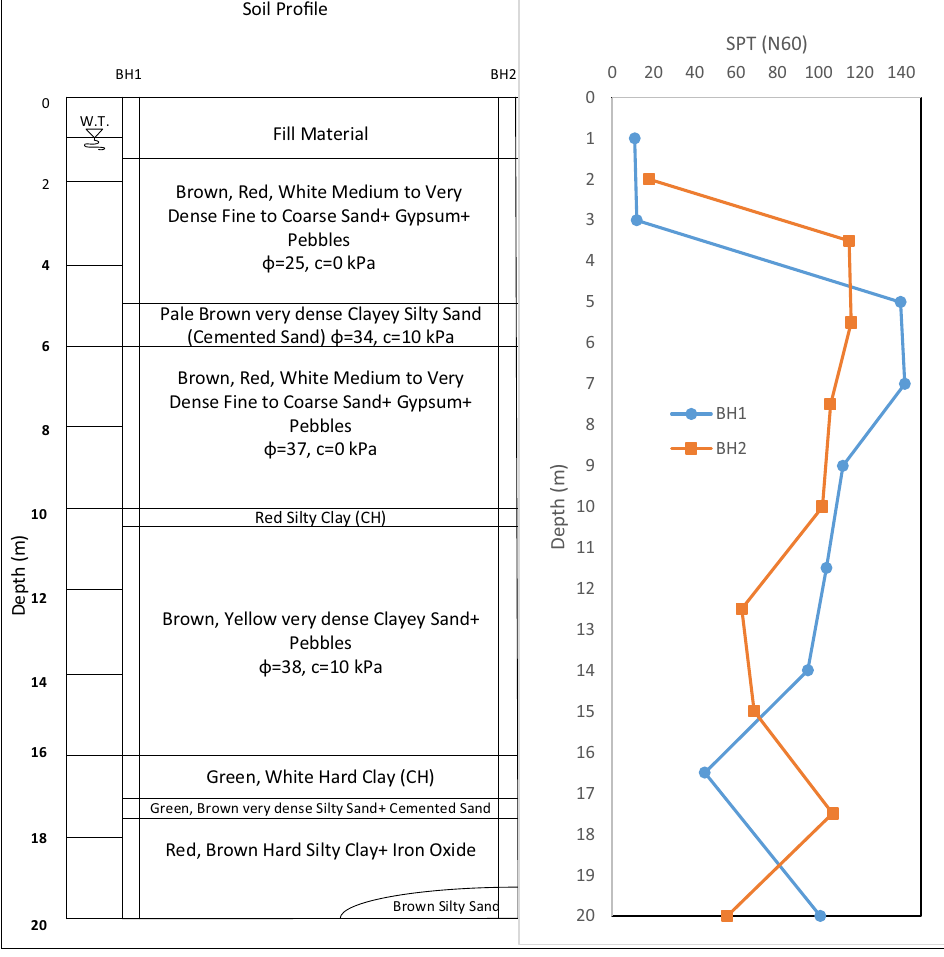
Figure 1: Soil pro fi le and corrected SPT ( N ) values for the test